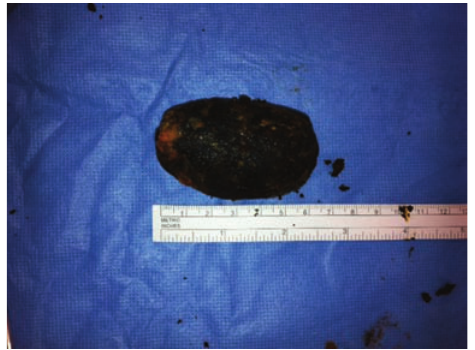
Figure 6: Removed gallstone measuring more than 6